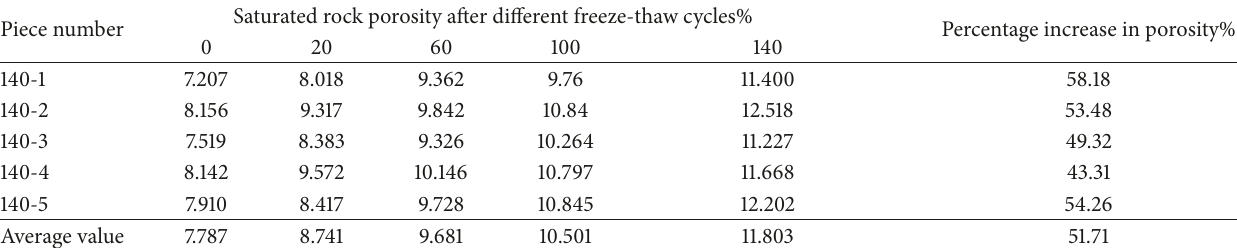
Table 2: Porosity variation of sandstone after different freeze-thaw cycles.